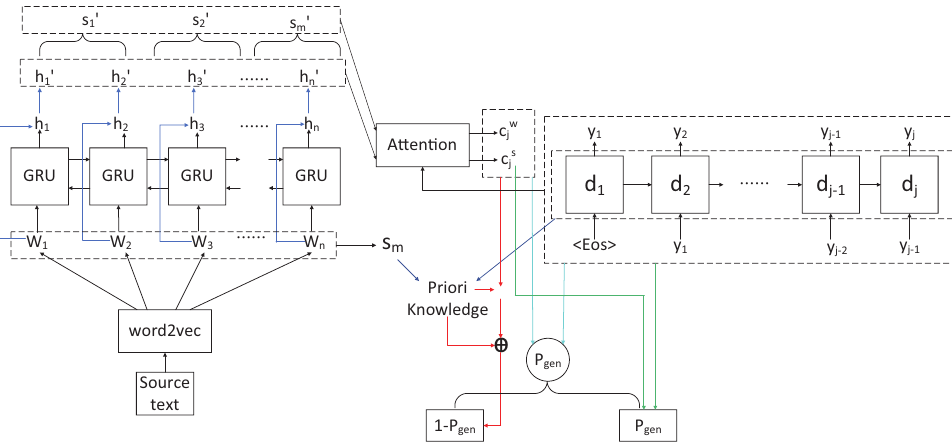
Figure 3. An abstractive summarization model based on joint-attention mechanism and a pri- ori